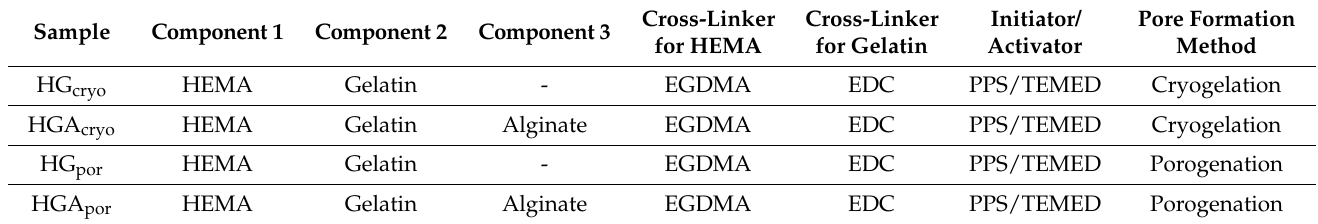
Table 1. Composition and marks of the hydrogel scaffold